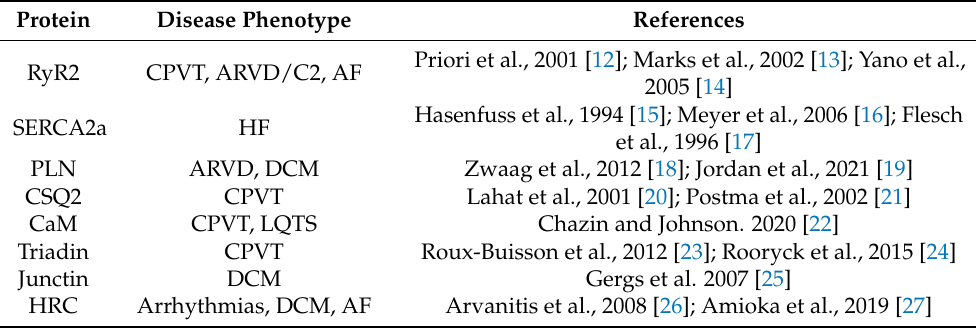
Table 1. SR Calcium Handling Protein Associated with Human Heart